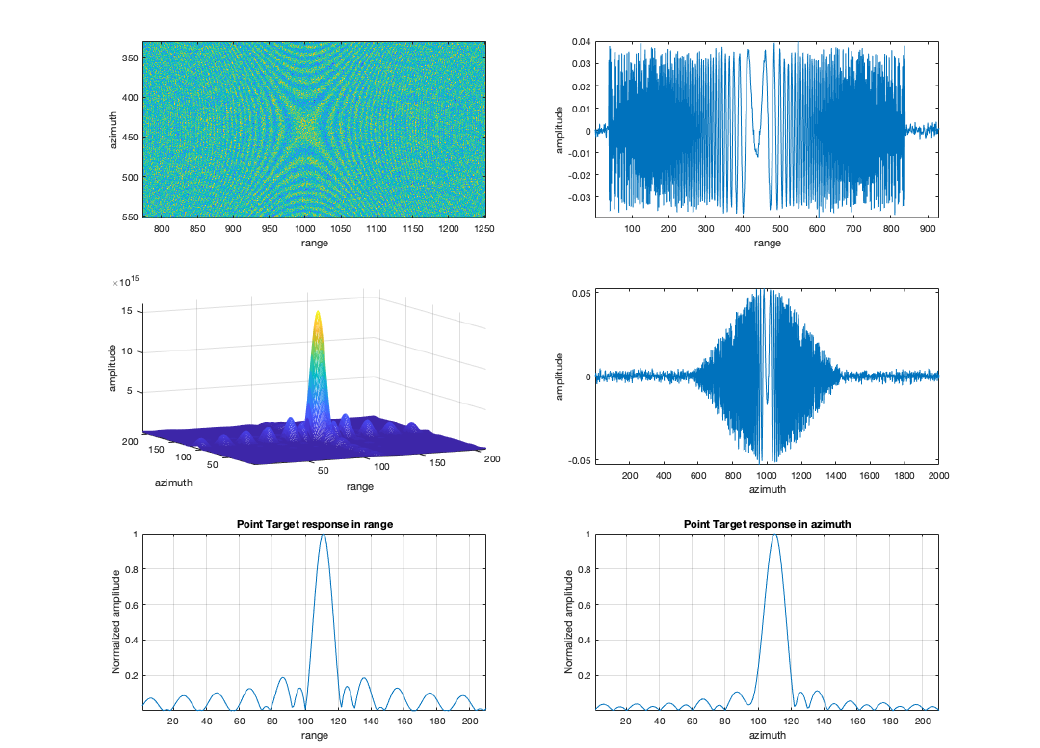
Figure 6. Results of simulated experiment. Top left: real part of the simulated (with additive gaussian noise) raw data; top right: First left singular vector as extracted from the SVD decomposition. center left: The 3D version of the ( × 10 interpolated) focused pulse detail of the simulated raw data with the B-SAR algorithm; center right: First right singular vector as extracted from the SVD decomposition. It refers to the azimuth direction, showing a (hamming simulated) shape of the antenna beam pattern; bottom left: the range cut of the interpolated focused pulse; bottom right: the azimuth cut of the interpolated focused